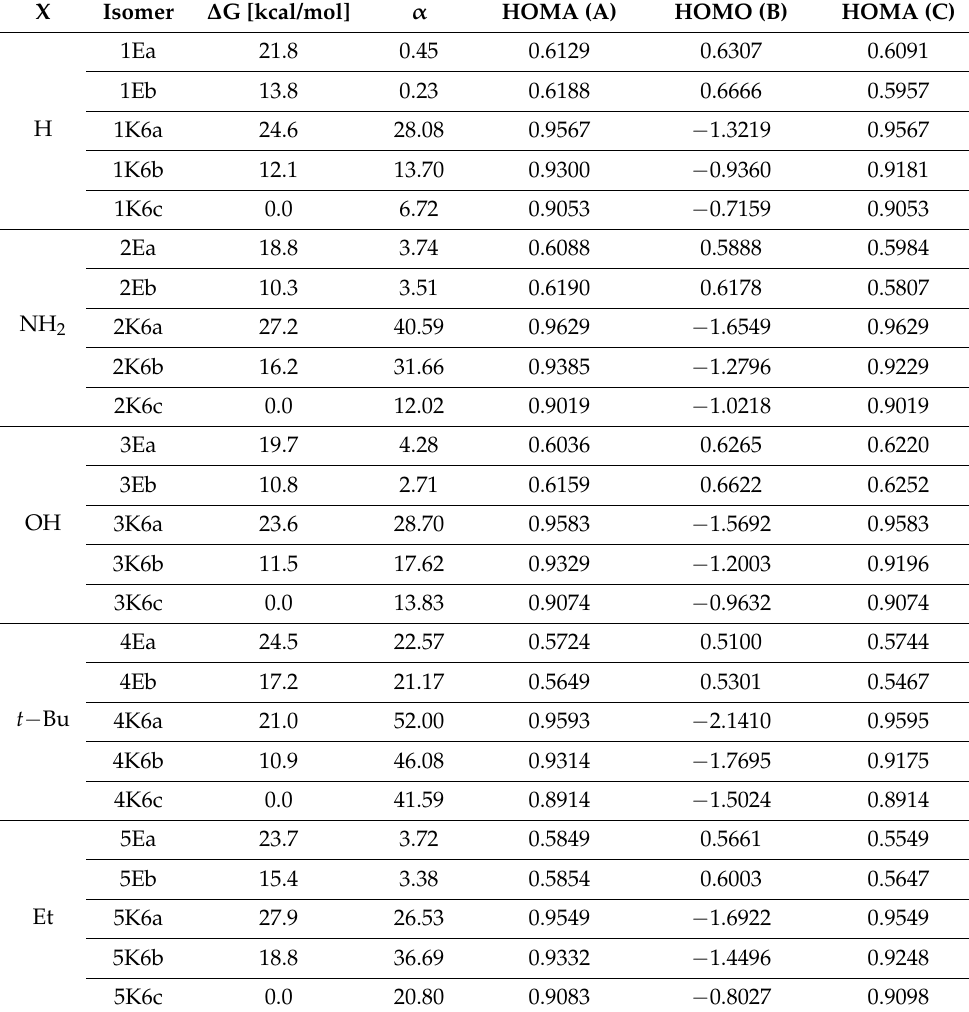
Table 2. ∆ G at 298 K, α and HOMA parameter for optimized structures of enol and ketone forms. Angle defined according to Scheme 1. For each substituent, the lowest energy has been obtained for the structure in the keto form with two hydrogen